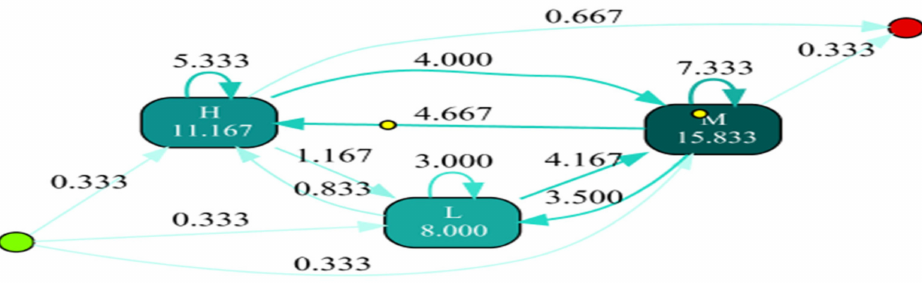
Figure 17. Relative paths for the DFvM model discovery.